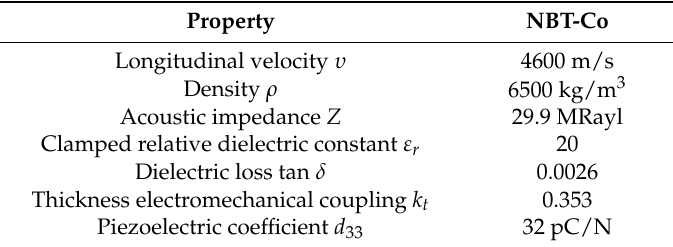
Figure 3. ( a ) Modelling results of Co-doped Na 0.5 Bi 4.5 Ti 4 O 15 (NBT-Co) single element transducer from Krimholtz, Leadom, and Mettaei (KLM) model-based simulation software PiezoCAD. ( b ) Simulated intensity profile in X-Z plane of NBT-Co transducer with ƒ-number of 1. Table 2. Parameters of Co-doped Na 0.5 Bi 4.5 Ti 4 O 15 (NBT-Co) ceramics used for PiezoCAD modeling.